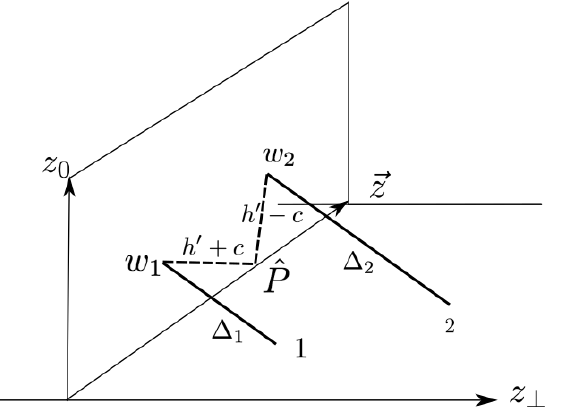
Figure 7 . Using the split representation of the bulk-to-bulk propagator the interface exchange Witten diagram is reduced to the product of two bulk-interface two-point contact Witten